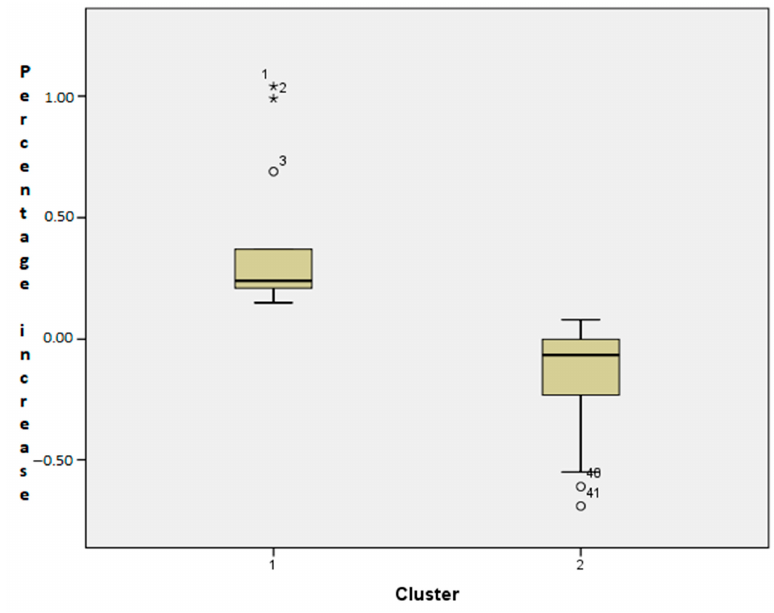
Figure 6. Box-plot cluster. Source: own processing using SPSS software. Normality tests for the two clusters can be seen in Table 8. Table 8. Test of Normality. Kolmogorov–Smirnov a Shapiro–Wilk Statistic df Sig. Statistic df